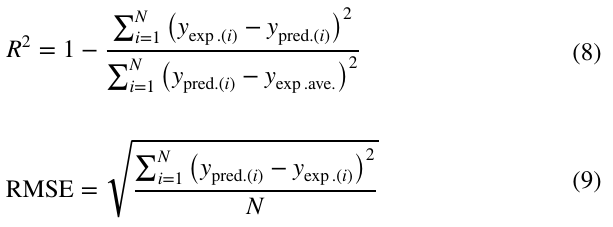
Table 1 Levels of independent variables for central composite design